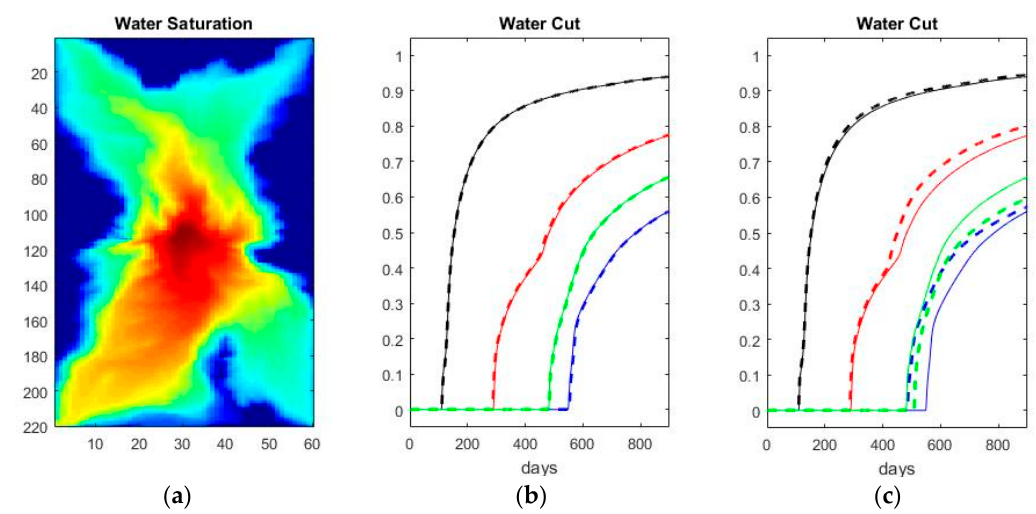
Figure 9. Results comparison in 2D reservoir ( a ) Final water saturation ( b ) water cut for the reduced model (78 sparse DMD modes) (dashed lines) and high-fidelity (solid lines) ( c ) water cut for the reduced model (78 POD modes) (dashed lines) and high-fidelity (solid lines). Table 2. Reservoir configuration.